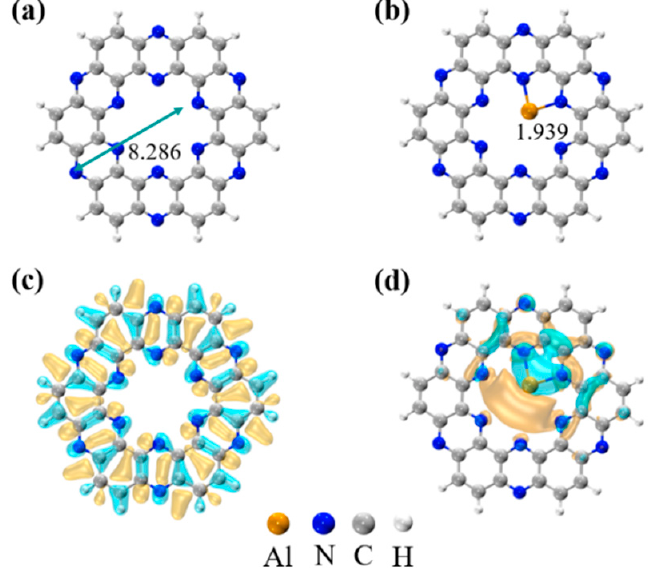
Figure 1. Optimized structures of the ( a ) pristine C 2 N cluster and ( b ) Al-C 2 N monolayer, respectively. Electron density difference plots (in 0.002 au) for ( c ) pristine C 2 N and ( d ) Al-C 2 N, respectively. Blue and yellow parts represent charge accumulation and depletion, respectively. All bond lengths are in Å.